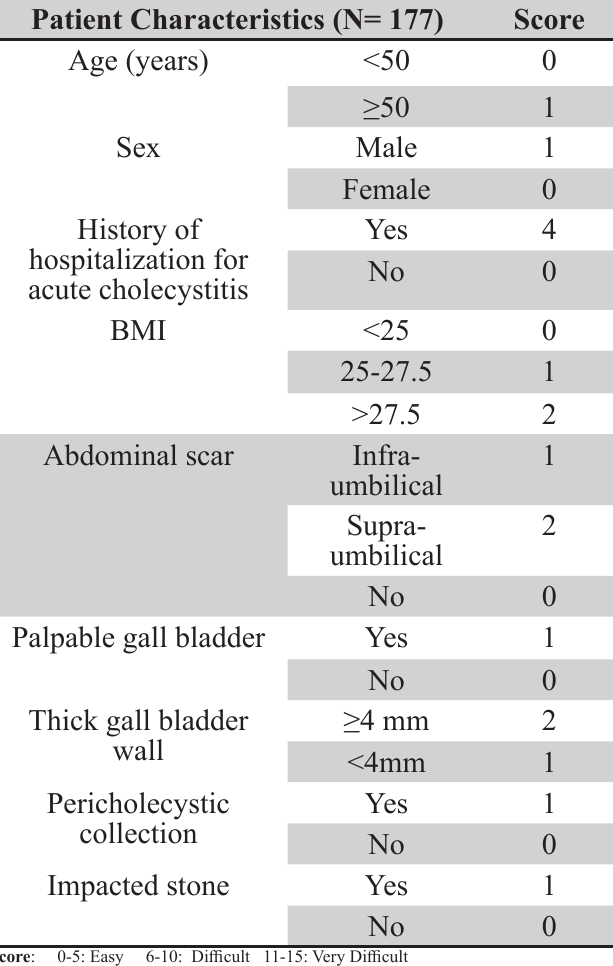
Table 1. Scoring factors used for grading the patient